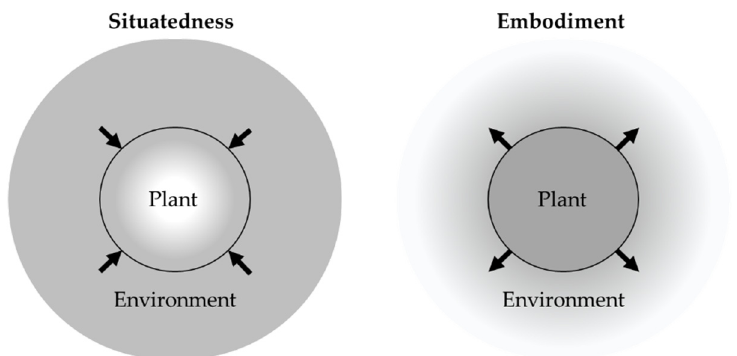
Figure 2. Interactions between an autonomous plant and its environment. A situated plant is affected by its environment, and an embodiment plant is part of the dynamic of the environment.